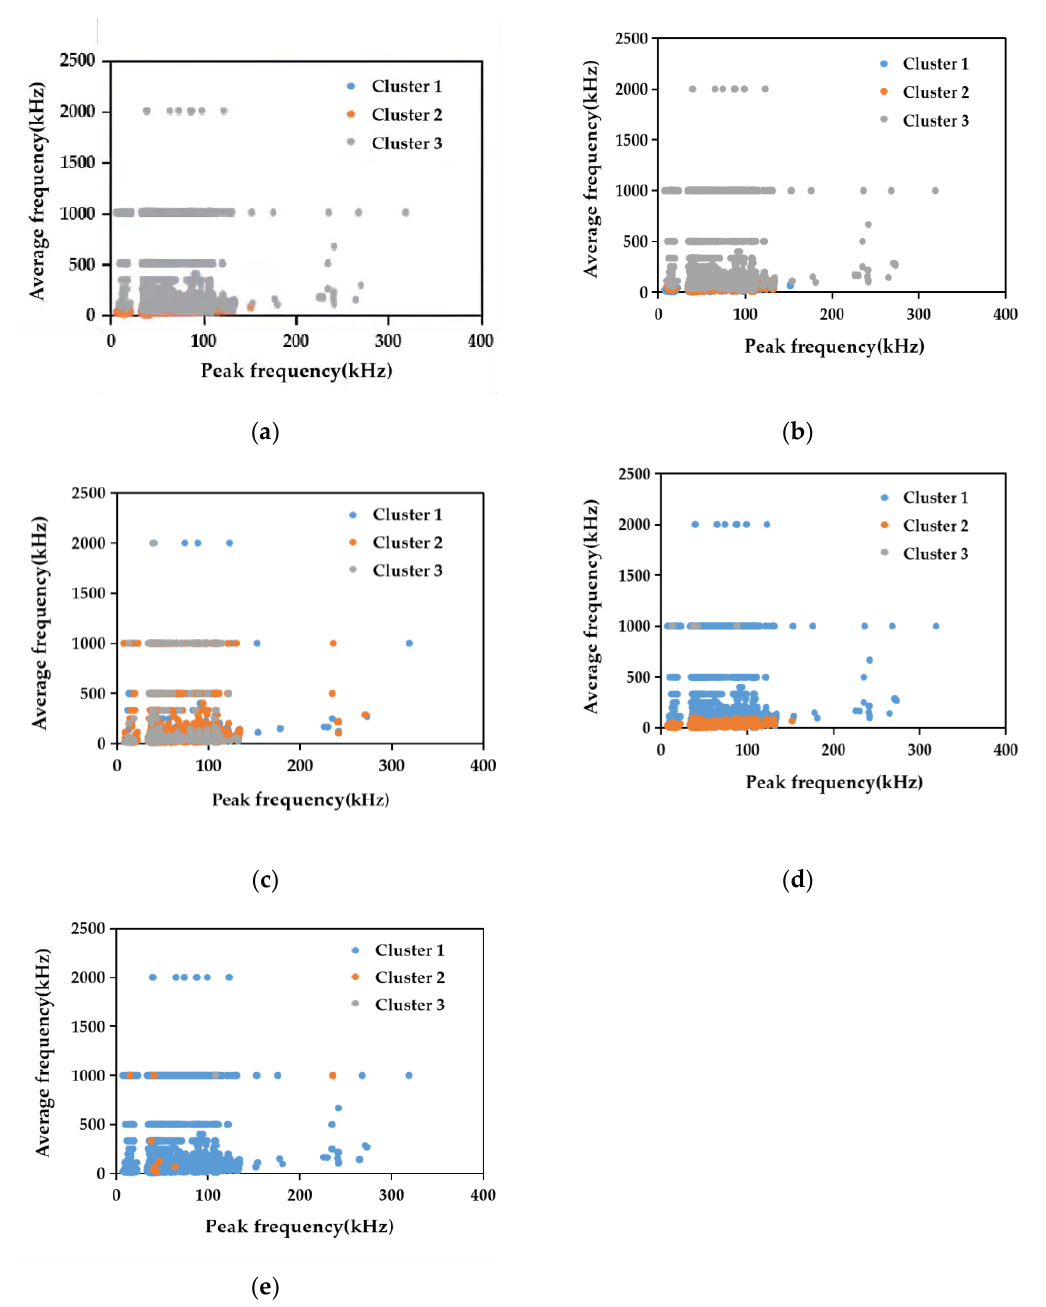
Figure 6. Clustering results of common clustering methods: ( a ) k-means clustering; ( b ) FCM clustering; ( c ) GMM clustering; ( d ) SOM clustering; ( e ) hierarchical clustering.